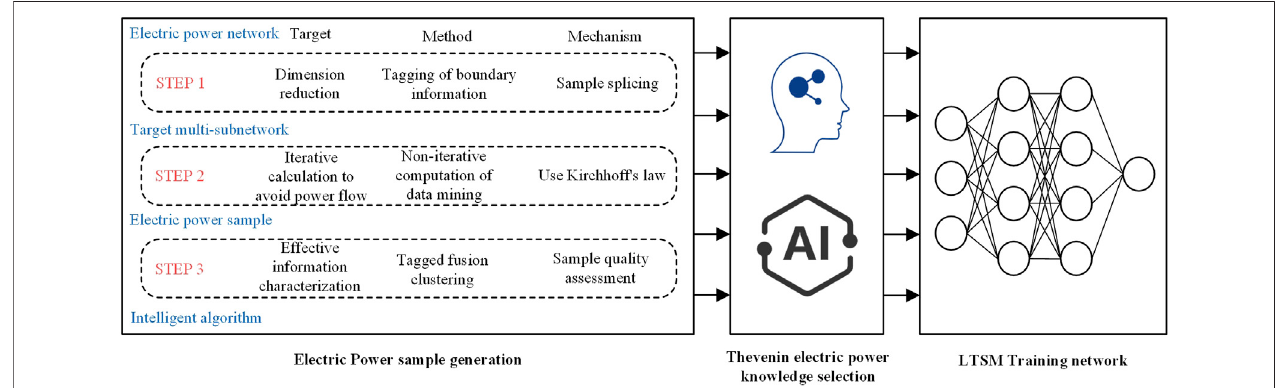
FIGURE 1 | Framework of networked microgrids with the individually local managers.